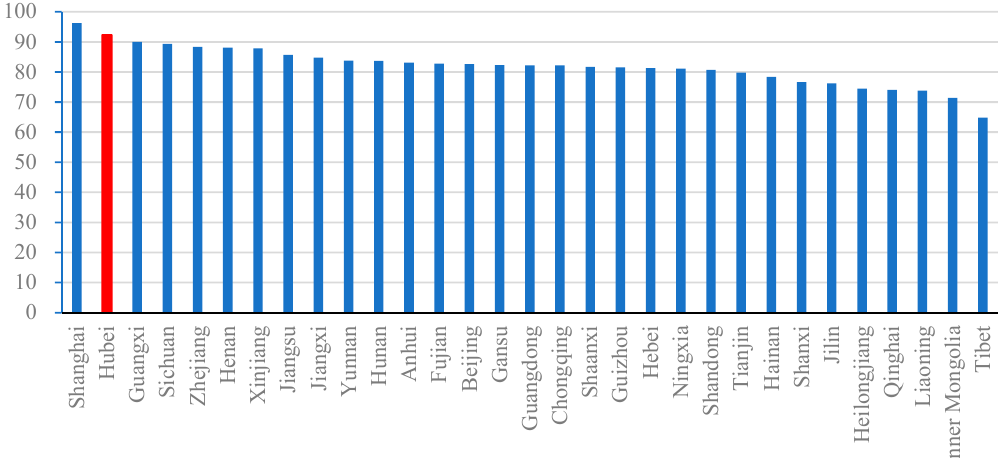
Figure 4. Utilization rate of hospital beds in 31 provinces in Mainland China in 2019 (%). Note: The bar in red shows the condition of Hubei, and the other bars are in blue. Data: National Health Commission of the PRC.